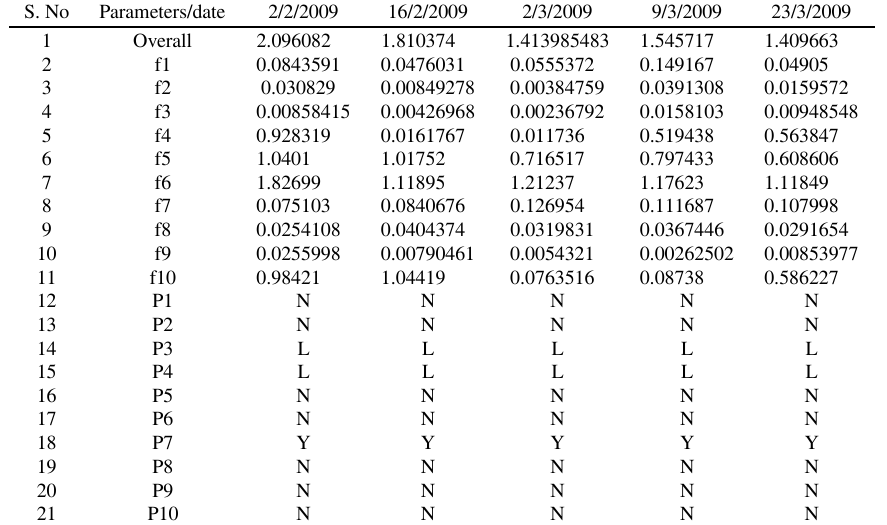
Table 2 Training data set for proposed SOFM network